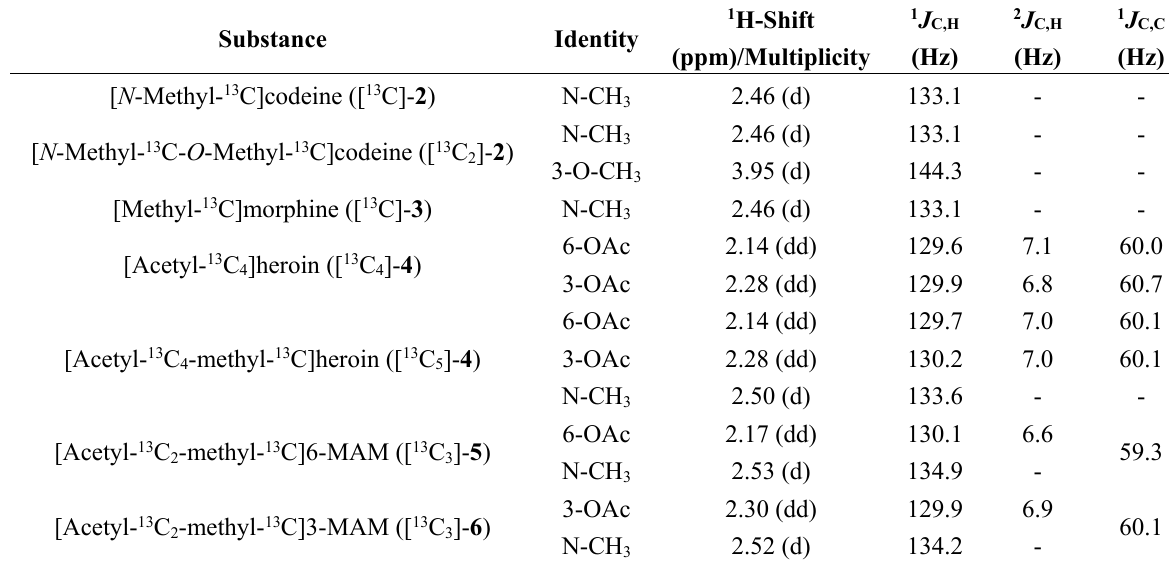
Table 1. Selected NMR spectroscopic data for the 13 C-labeled compounds, 2 – 6 .